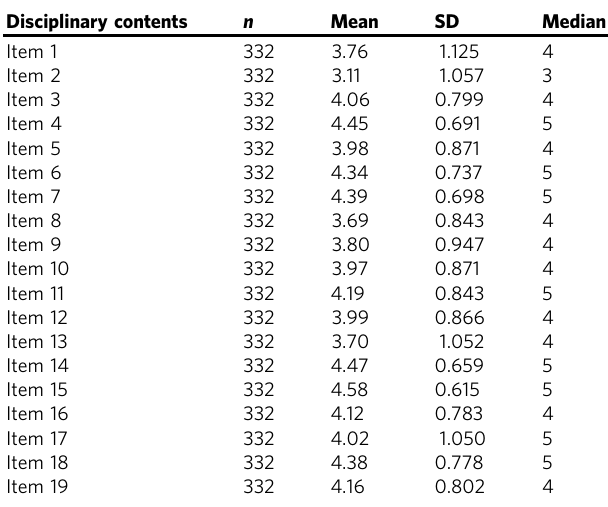
Table 5 Measures of central tendency on the relevance